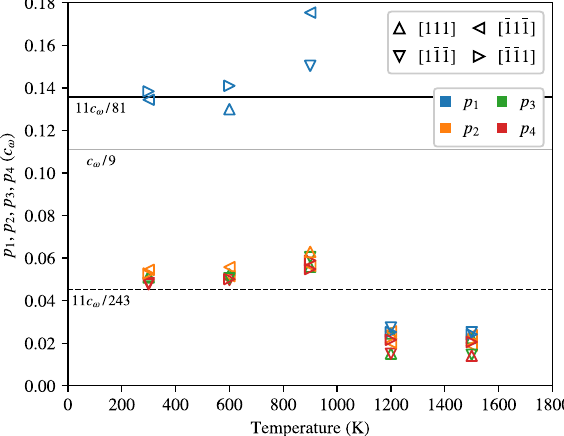
Fig. 5 Projected displacements of the average MD positions of TiZrHf at the bcc lattice parameter of ≈ 3.469 Å . The projection directions are distinguished by the orientation of the triangular markers. The solid and dashed horizontal lines indicate the projection amplitudes for the ideal (perfect and defective ω ) cases provided in Table 1.